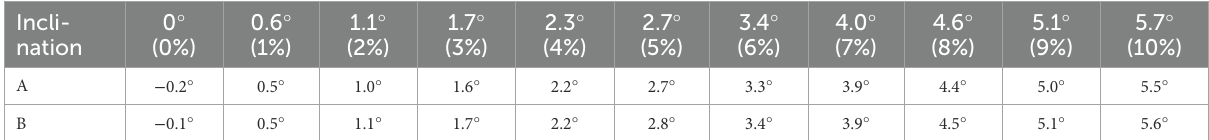
TABLE 3 Measured inclination in degree of both treadmills (A, B) for the indicated inclination. Incli-